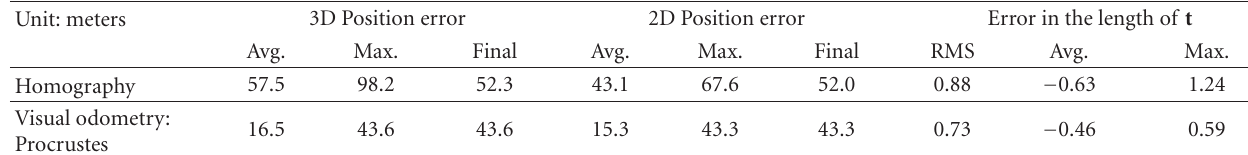
Table 2: Comparison of visual odometry with the GPS reference. All values are given in